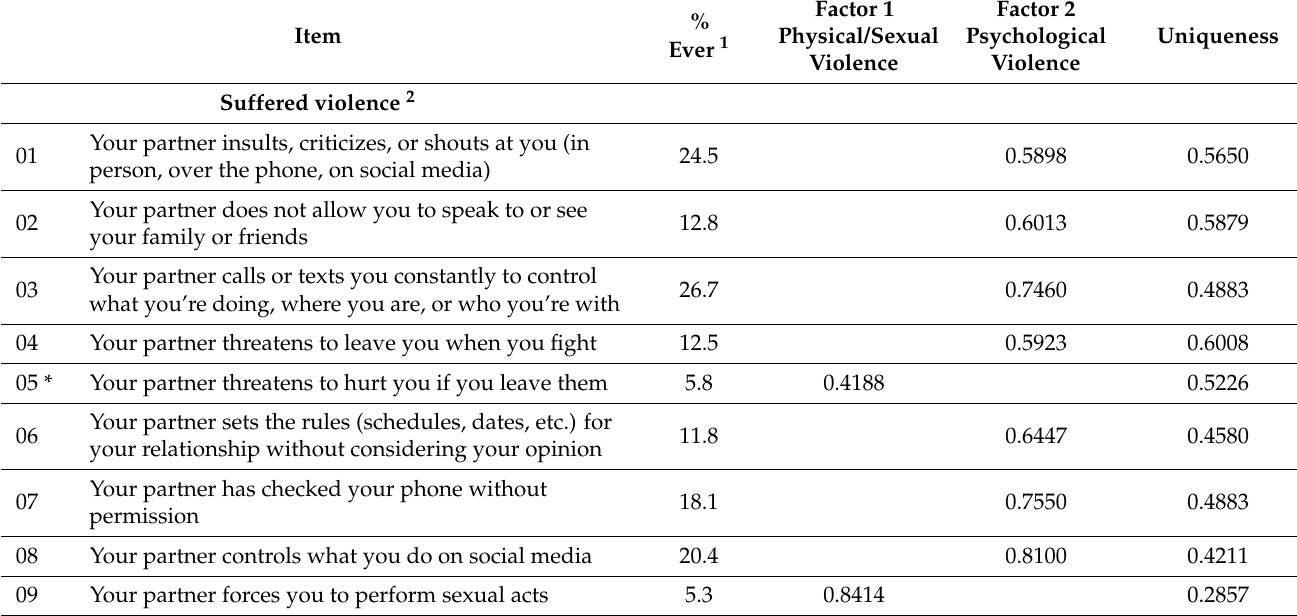
Table 1. Matrix with factor loadings from principal component analysis with Promax